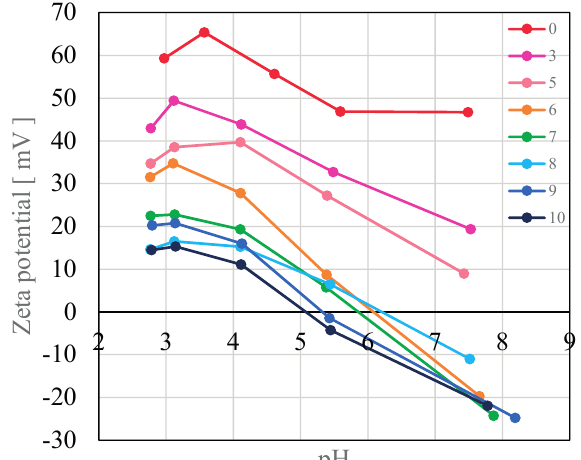
Figure 2. The dependence of the surface zeta potential during preconditioning. For example, the red graph is data of the membrane without the preconditioning. The dark blue graph is data of the membrane with the preconditioning for 10 days.